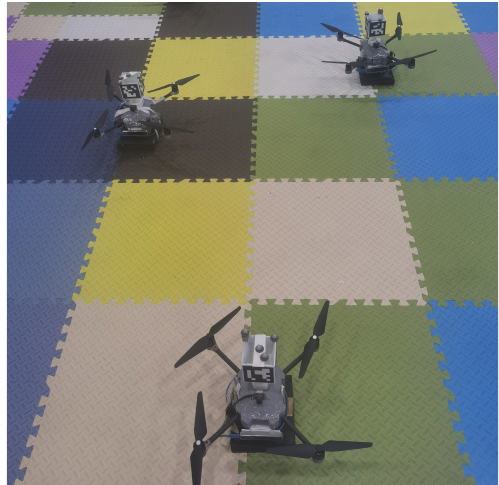
Figure 15. Experiment